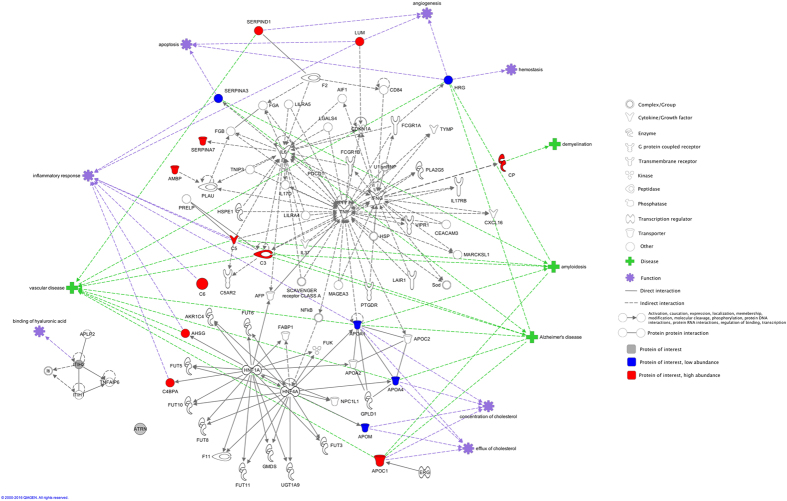
Protein network (IPA) of the proteins differentially abundant in NC, aMC and sMC groups.IPA analysis of the differentially abundant proteins (denoted by their gene names, refer to Table 2), which are coloured in red (increased abundance in sMC vs NC), blue (decreased abundance in sMC vs NC) and grey (differentially abundant in NC, aMC and sMC but not in sMC vs NC comparison). Prevalent functions and disease processes related to the proteins are indicated in the network by purple and green symbols, respectively.